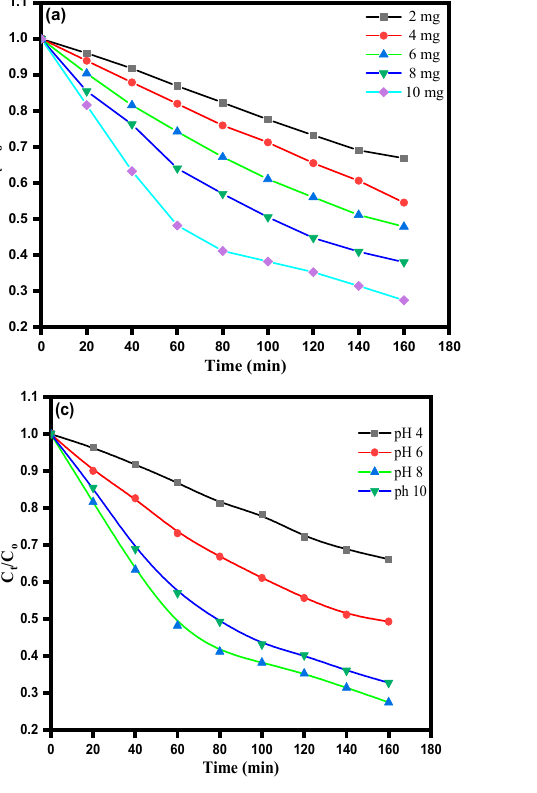
Figure 11. ( a ) Kinetic photodegradation of ciprofloxacin (CIP) at varying doses of nanocatalyst; ( b ) kinetic photodegradation at various initial concentrations of CIP molecules at a constant nanocatalyst dose; ( c ) pH-dependent kinetic photodegradation of ciprofloxacin (CIP) in the presence of a nanocatalyst (LP-ZnO); ( d ) effect of various scavengers on the photocatalytic degradation of ciprofloxacin in the presence of LP-ZnO NPs.